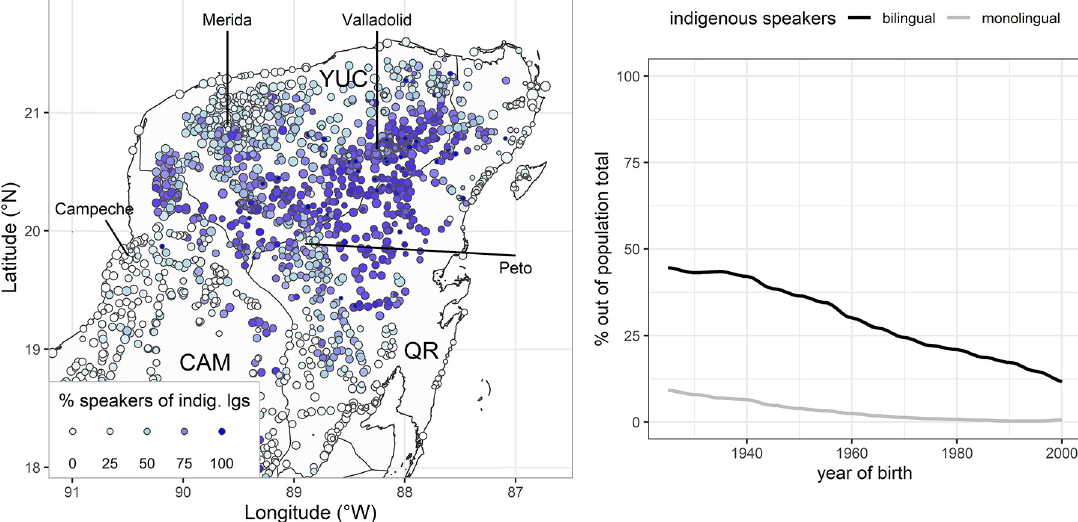
Fig 1. Indigenous speakers in space and time. (A) Diffusion of the indigenous languages’ speakers in space; Proportions of speakers of indigenous languages, plotted in the color scale; Point size: Logarithmized population size of the community (Mexican states: YUC = state of Yucata´n; QR = state of Quintana Roo; CAM = state of Campeche). (B) Diffusion of indigenous languages’ speakers in Time. The graphs were created in R [36]; ggplot2 package for plots [37], ggmap package for maps [38]; see package versions and further information in S3 File . Geographical data were downloaded from the Database of Global Administrative Areas (GADM, version 3.6, 2020) at https://gadm.org/.